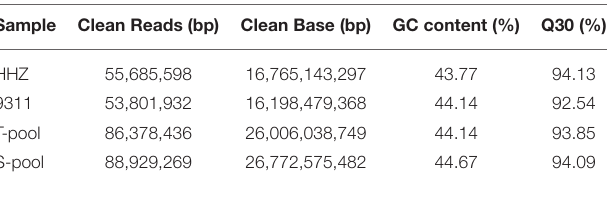
TABLE 1 | The quality of sequencing data.